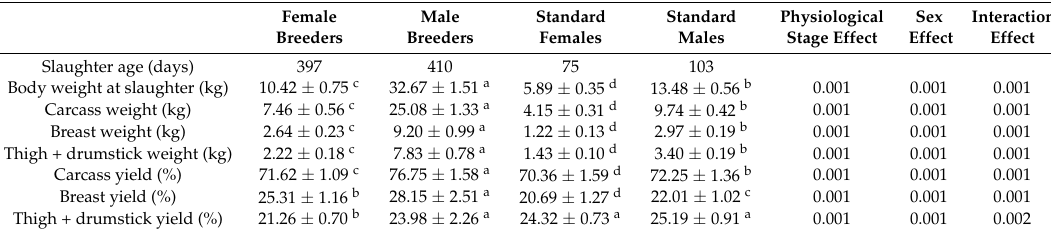
Table 1. Meat yields of males and females of breeder and standard turkeys ( n = 20).